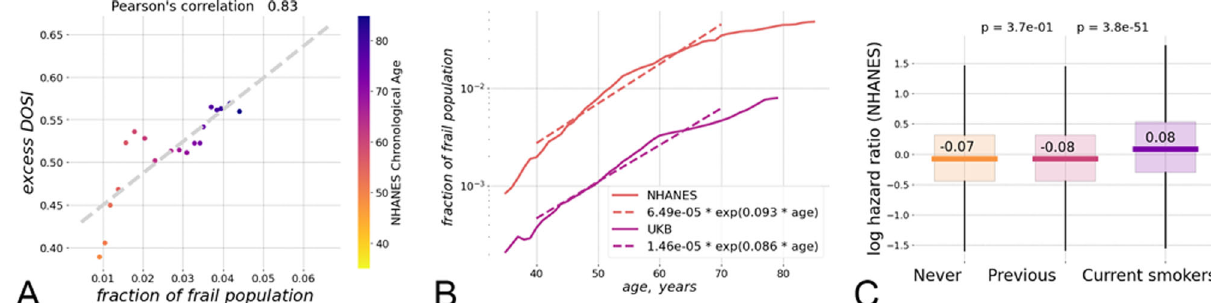
Fig. 2 The relation between the dynamic organism state indicator (DOSI) and lifestyles, frailty, and health risks. A Fraction of frail persons is strongly correlated with the excess DOSI levels, that is the difference between the DOSI of an individual and its average and the sex- and age-matched cohort in the “ non-frail ” population in NHANES. B Exponential fi t showed that until the age of 70 y.o. the fraction of the “ most frail ” individuals in the population grows approximately exponentially with age with the doubling rate constants of 0.08 and 0.10 per year in the UKB and the NHANES cohorts, respectively. C Distribution of log-hazards ratio in age- and sex-matched cohorts of NHANES participants who never smoked, smoked previously but quit prior to the time of study participation, or were current smokers at the time of the study. The DOSI level is elevated for current smokers, while it is almost indistinguishable between never-smokers and those who quit smoking (two-sided Mann – Whitney test p > 0.05). Each boxplot shows the center (median) of the distribution, boxplot bounds show the 25 and 75% percentiles and boxplot whiskers show the 5 and 95%